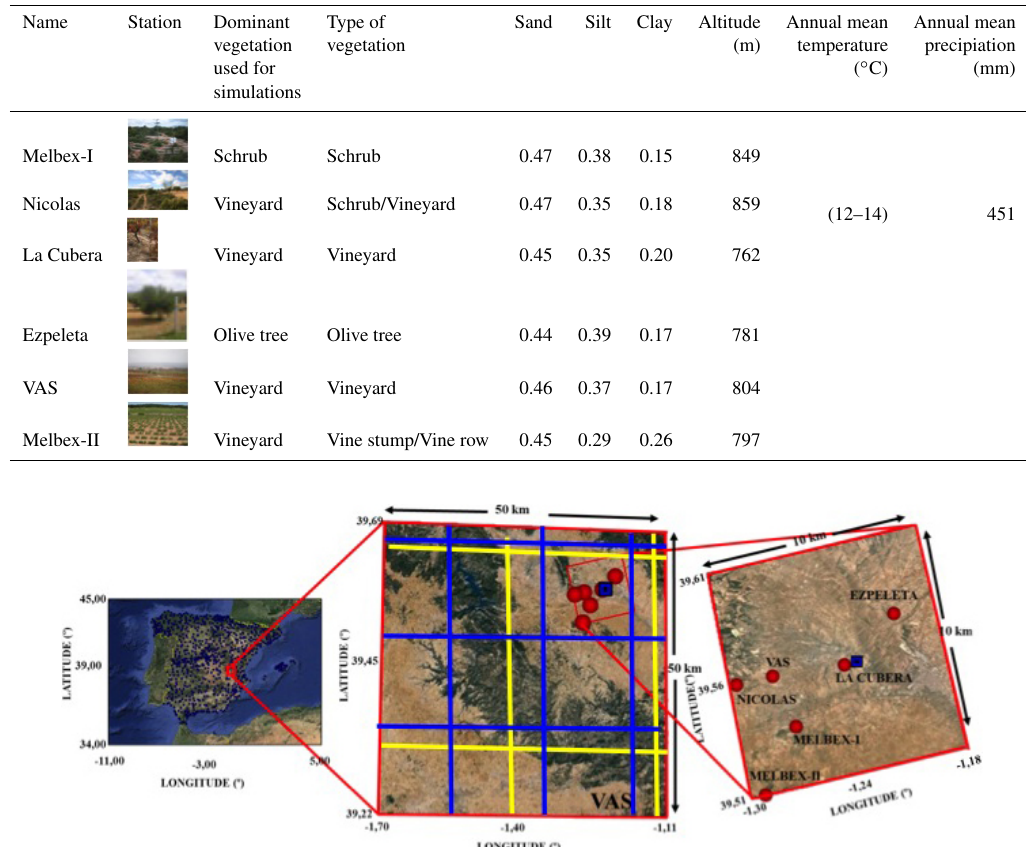
Table 1. Characteristics of soil moisture stations within the VAS domain.